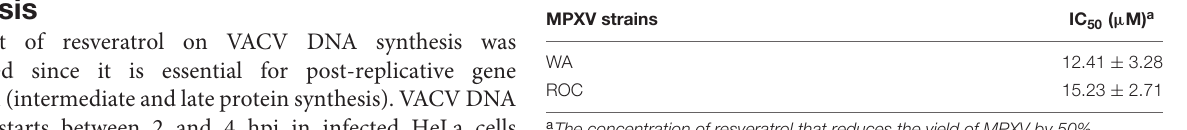
presence of hydroxyurea, which allowed early gene expression.